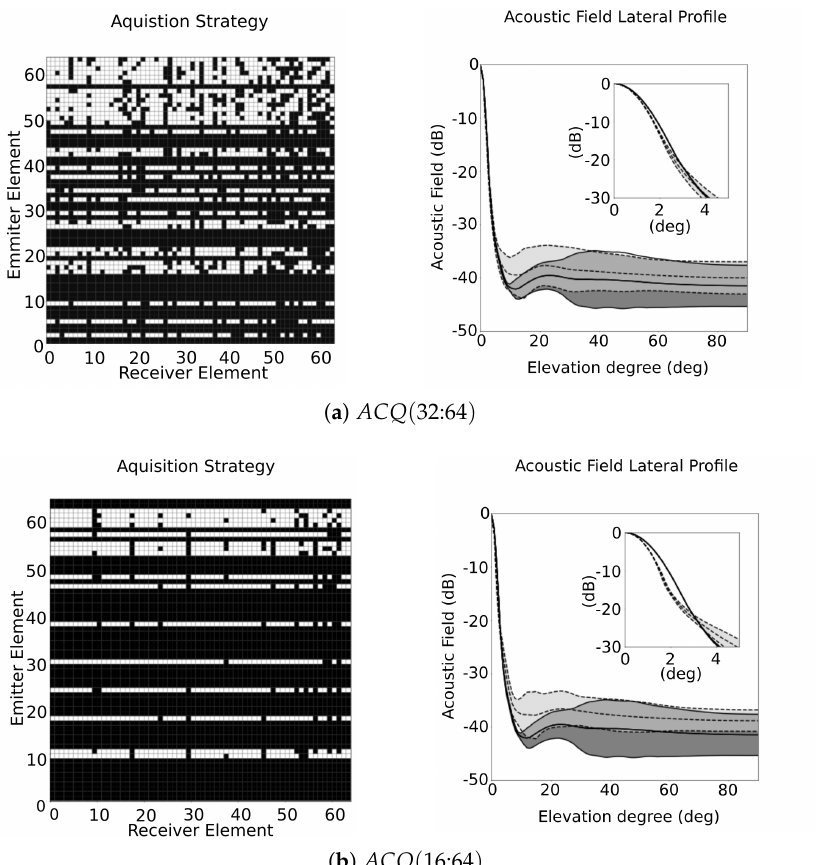
Figure 8. Acquisition strategy and sidelobes distribution at each elevation angle for ( a ) ACQ ( 32:64 ) and ( b ) ACQ ( 16:64 ) , where the distribution of the respective ACQ is represented in light grey area within the dashed lines, and the FMC is represented as dark grey area within the solid